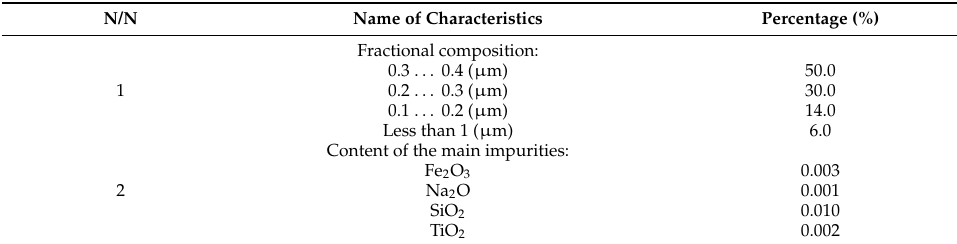
Table 1. Characteristics of γ -Al 2 O 3 .